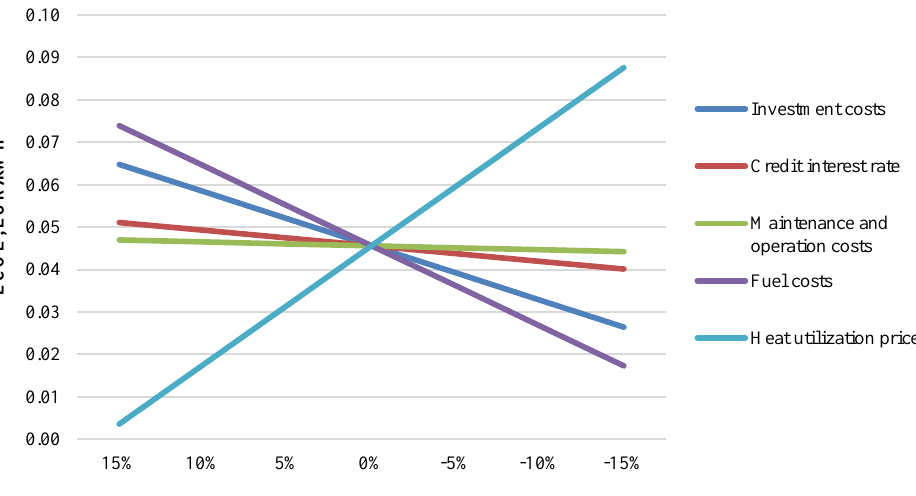
Fig. 6. Parameter sensitivity